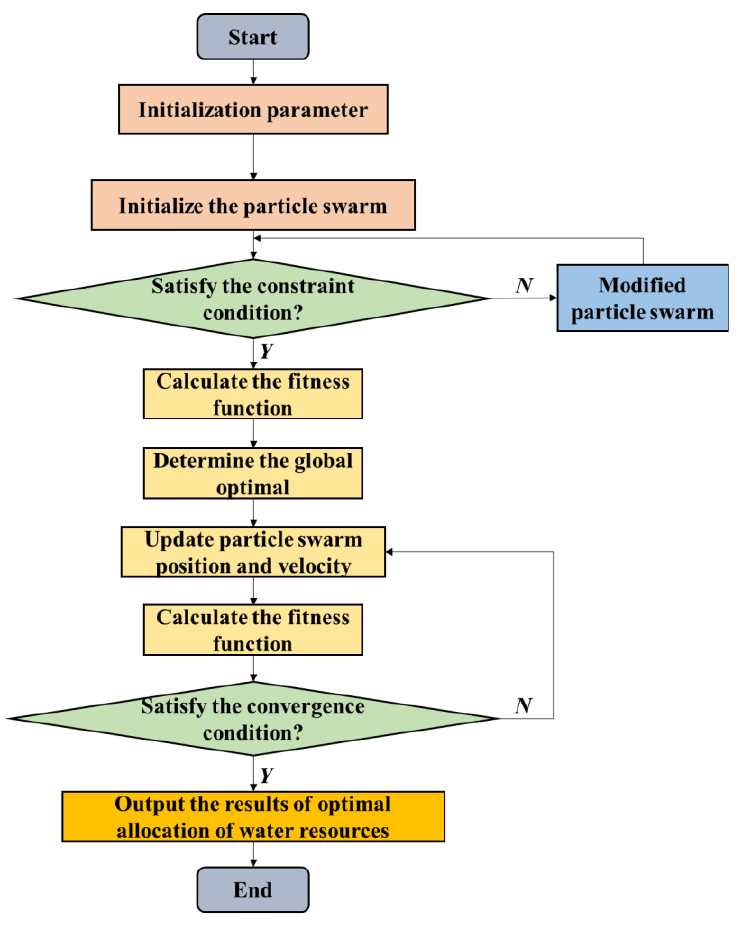
Figure 2. Flow chart of particle swarm optimization algorithm.